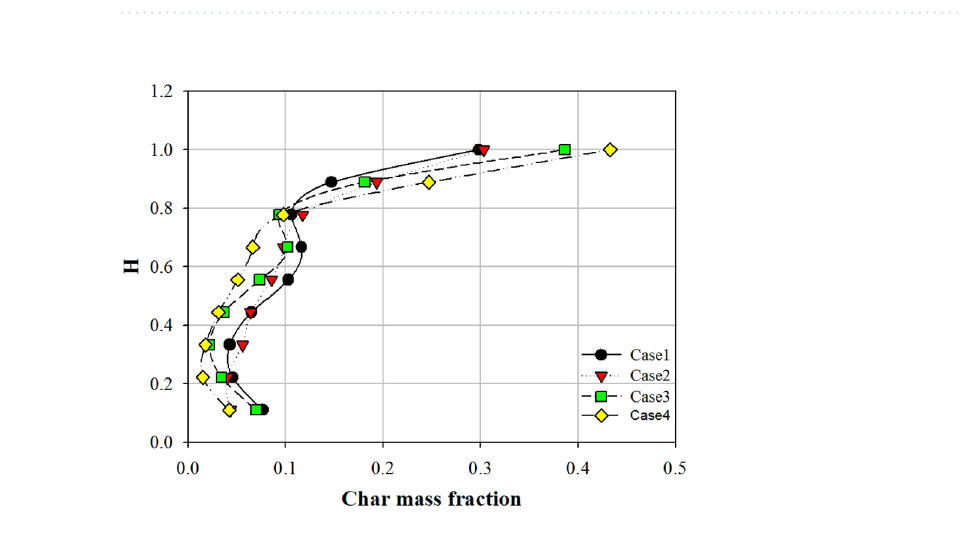
Figure 11. Contours of bio-char mass fraction for different shapes of fluidized bed columns.